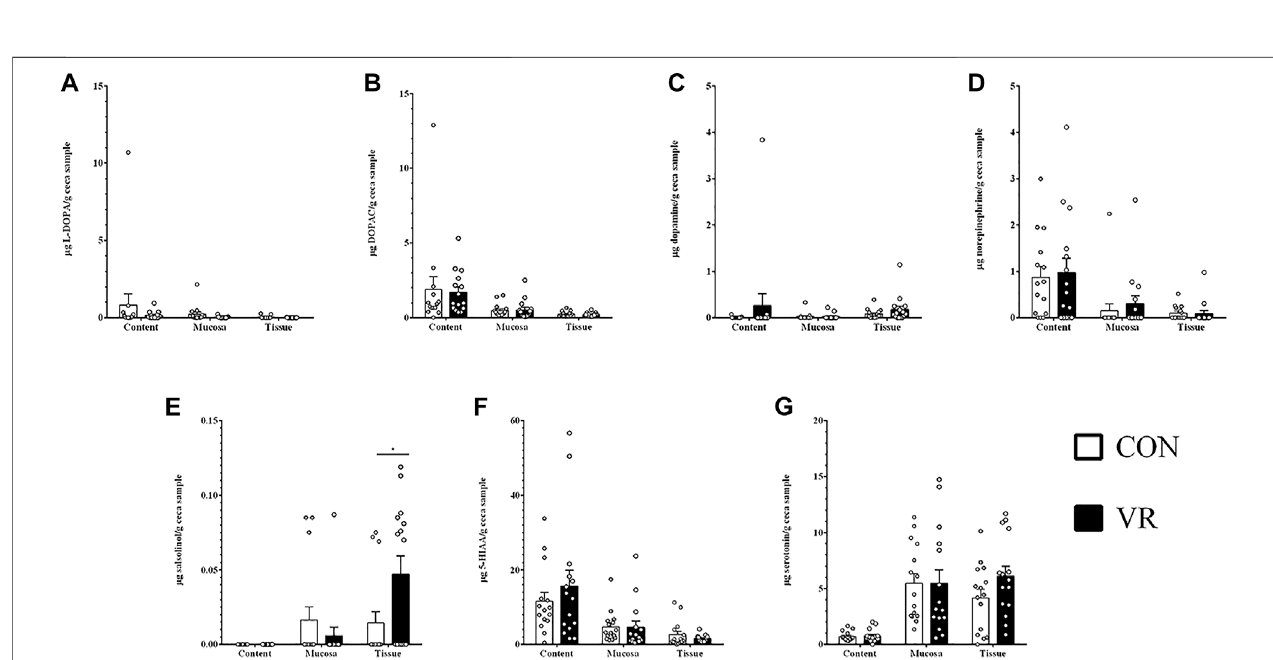
FIGURE4| Neurochemicalmetabolitelevelsinchickenceca( n =15/group)measuredbyU-HPLC. (A) ,L-DOPA. (B) ,DOPAC. (C) ,dopamine. (D) ,norepinephrine. (E) , salsolinol. (F) , 5-HIAA. (G) , serotonin.